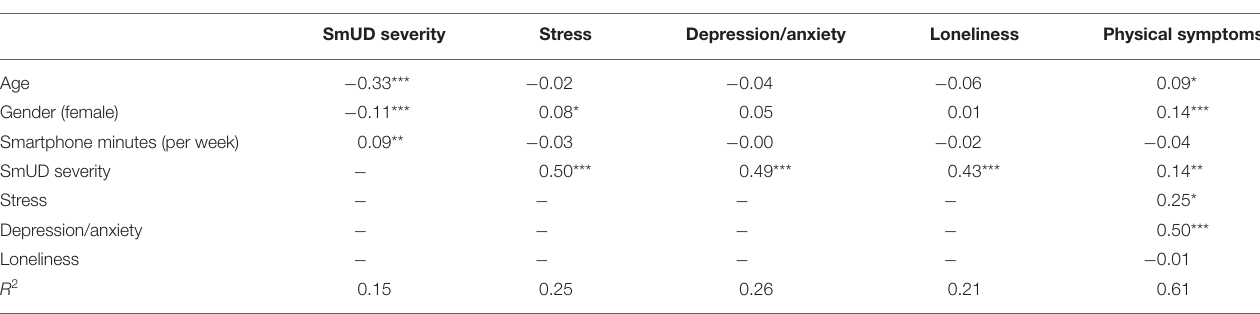
TABLE 2 | Complete matrix of model path weights.